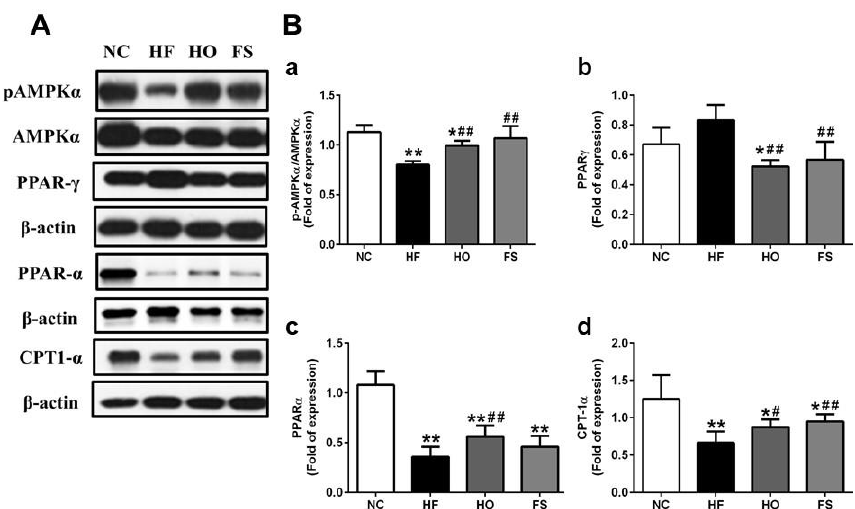
Figure 3. Effects of RMD and orlistat on the protein expression of lipid metabolism-related signaling molecules in the livers of HF-diet-fed rats. Protein expression for pAMPK α /AMPK α , PPAR- α , PPAR- γ , and CPT-1 α in the livers of HF-diet-fed rats treated with or without RMD and orlistat for 8 weeks are shown ( A ). Protein expression was determined by Western blotting. Densitometric analysis for protein levels corrected to each internal control is shown ( B ). Results are expressed as mean ± S.D. for each group ( n = 4–6). * present p < 0.05, ** present p < 0.01 as compared with NC group; # present p < 0.05, ## present p < 0.01 as compared with HF group. NC: normal control diet; HF: high-fat diet; HO: high-fat diet containing 0.2% orlistat; FS: high-fat diet containing 5% Fibersol-2.